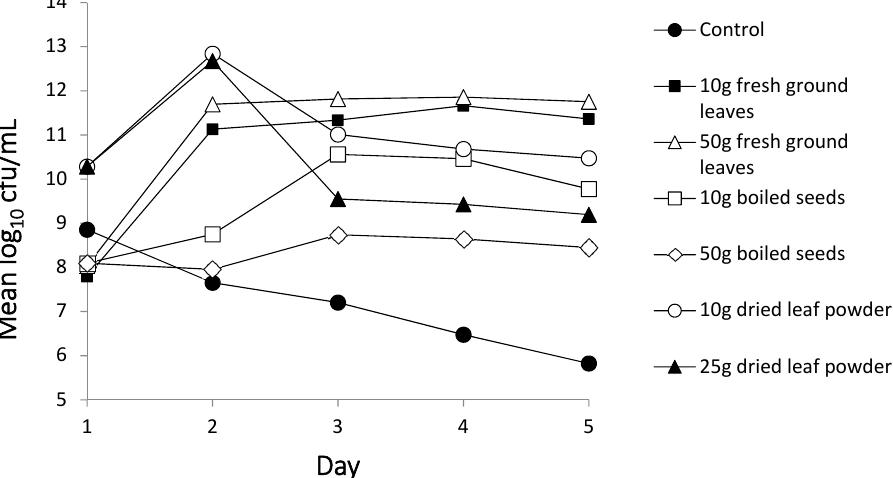
Figure 1. Mean log 10 cfu/mL of E. coli in bottles containing different preparations of Moringa oleifera compared to Controls, Days 1–5.